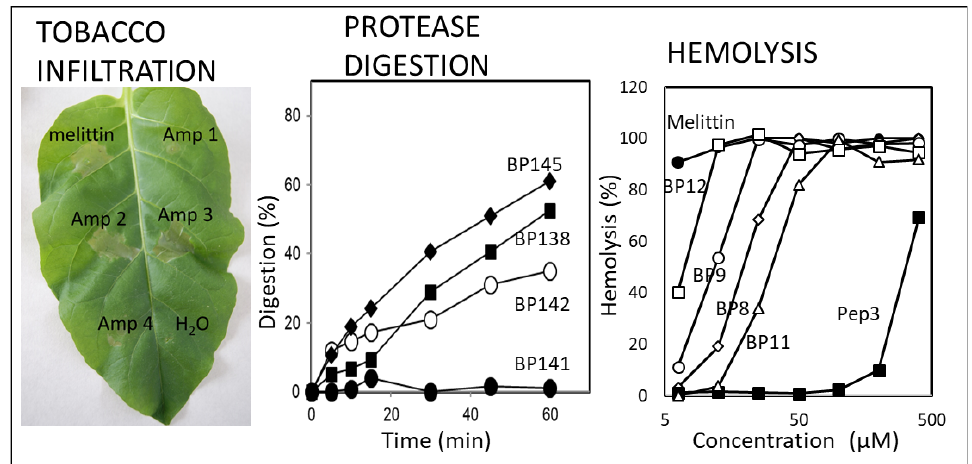
Figure 4. Examples of results obtained for different peptides related to phytotoxicity on tobacco leaves to the susceptibility to protease degradation using proteinase K and to the hemolytic activity using blood erythrocytes. Data from Ferre et al. and Güell et al. [36,40].